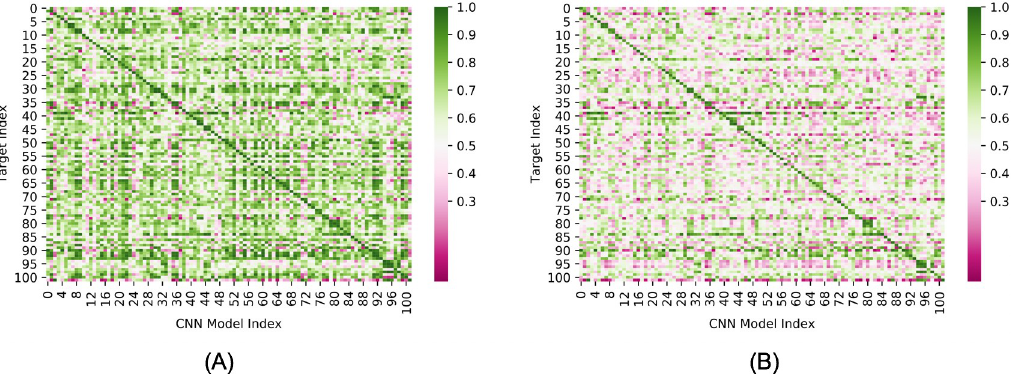
Fig 9. Inter-target prediction performance of ligand-only CNN models. (A) Ligand-only CNN model tested on test sets composed of actives and default decoys (B) Ligand-only CNN model tested on test sets composed of actives and AD decoys. The target order is the same as in